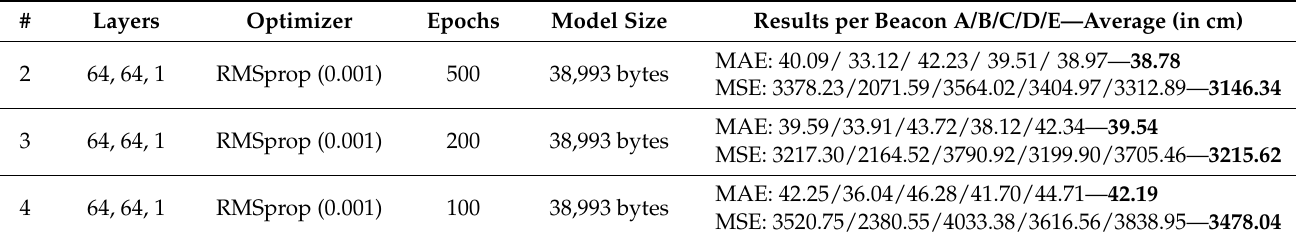
Table 3. Experiments No. 2, No. 3, and No. 4 parameters and results.